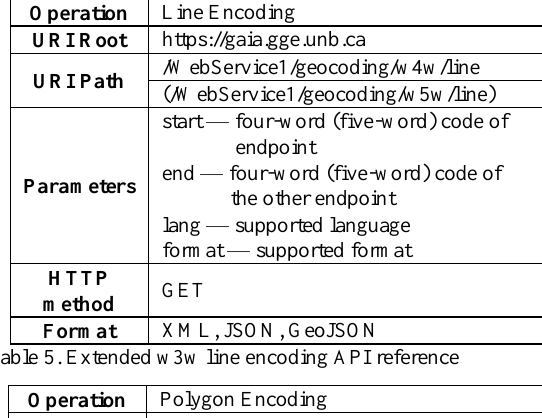
Table 5. Extended w3w line encoding API reference